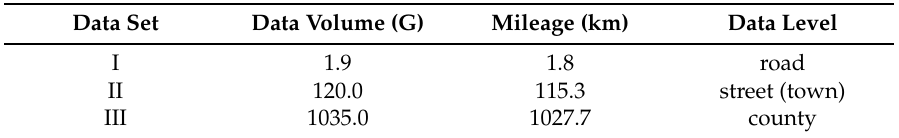
Table 1. Experimental GRID data